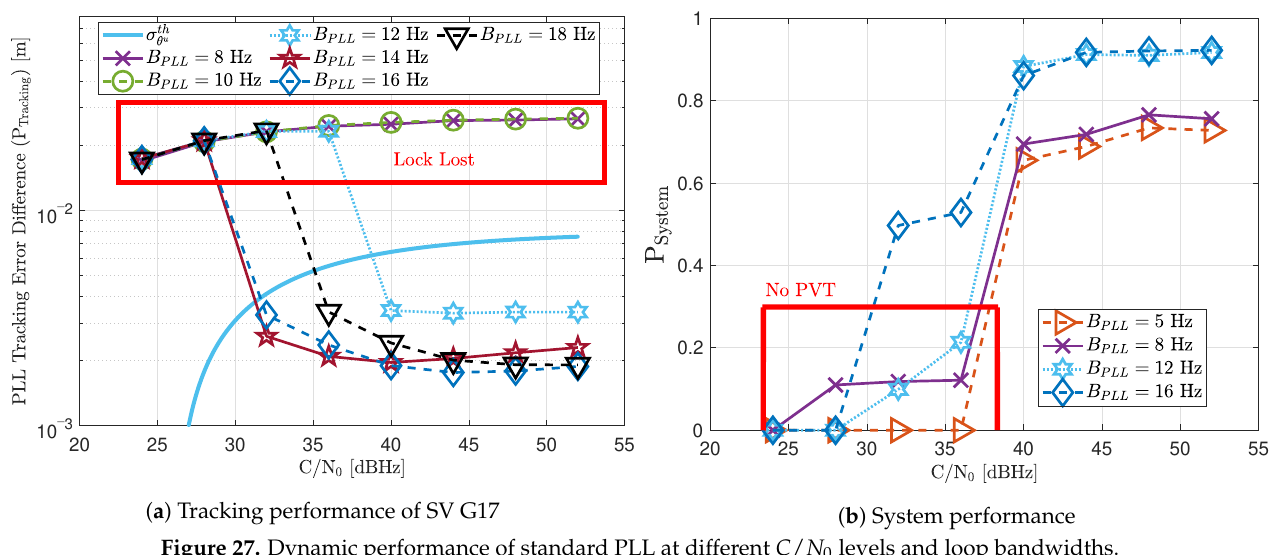
Figure 27. Dynamic performance of standard PLL at different C / N 0 levels and loop bandwidths.